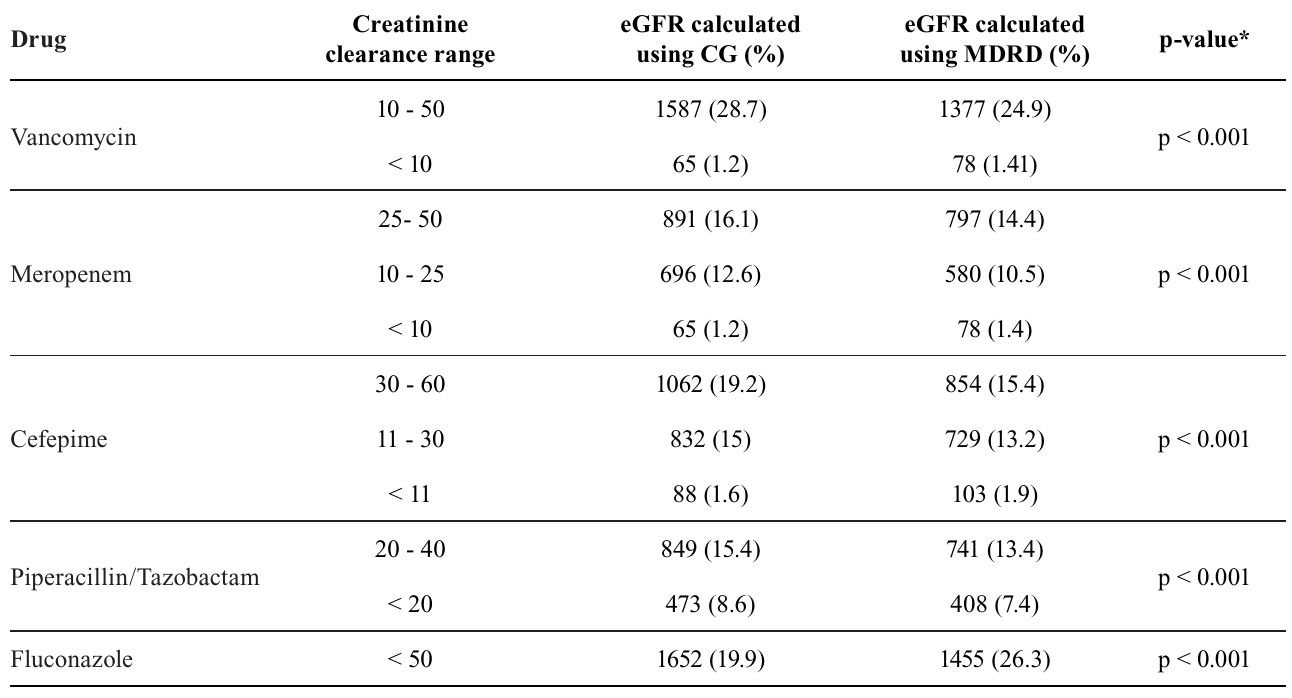
Table II - Frequency of dose adjustment according to recommended for each estimated glomerular filtration range calculated using CG or MDRD for broad-spectrum antimicrobials (N=5,528)